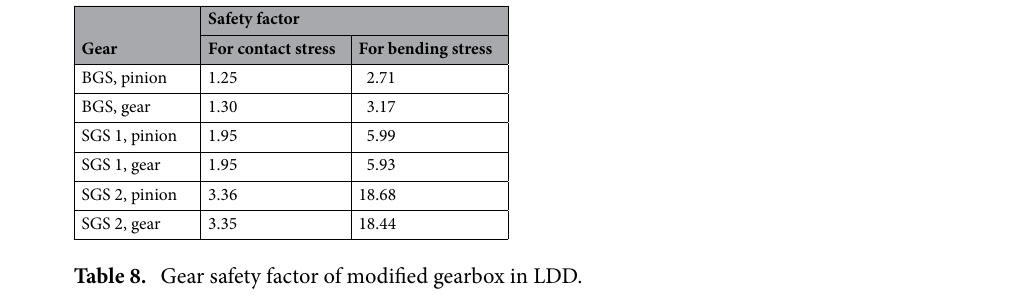
Table 8. Gear safety factor of modified gearbox in LDD.